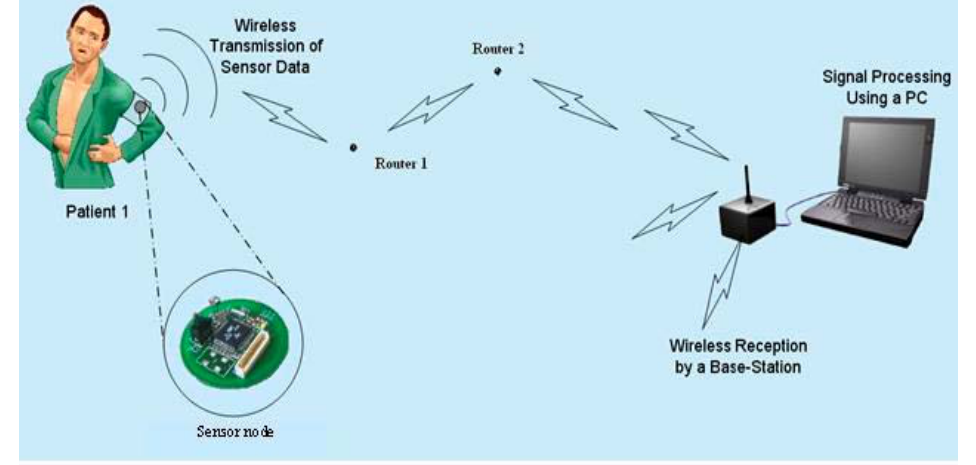
Figure 1. Remote vital sign monitoring system. (Original figure source: http://www.enel.ucalgary.ca/People/Haslett/WCLM/CCHE/WebPage/VijayDevabhaktuni_Wireless_Proceeding